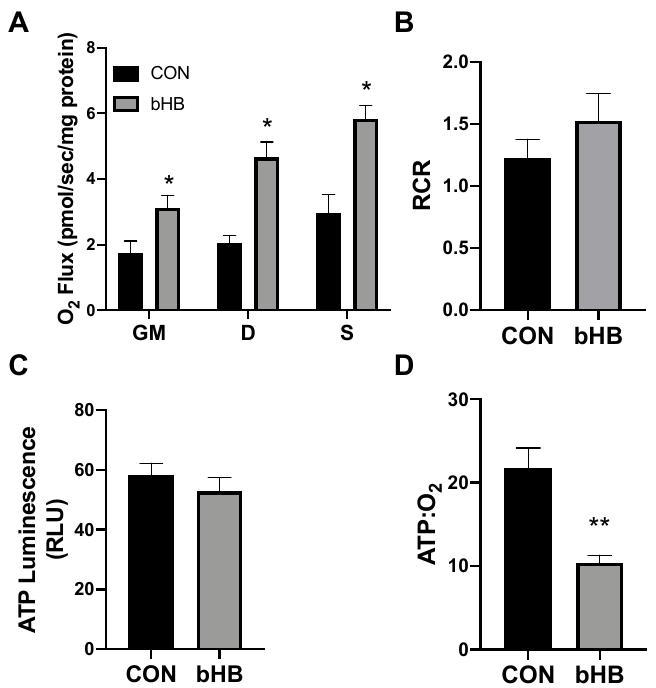
Figure 1. β -hydroxybutyrate ( β HB) alters mitochondrial bioenergetics in cultured adipocytes. Following 24-h treatment with β HB (5 mM), the adipocytes were harvested and used to measure the mitochondrial respiration ( A ) and respiratory control ratio (RCR; B ) in adipocytes. Permeabilized adipocytes were sequentially treated with glutamate (10 mM) and malate (2 mM; GM); +ADP (D; 2.5 mM); +succinate (S; 10 mM). ATP was measured via luminescence from freshly lysed cells ( C ), and the ratio of ATP and respiration was quantified ( D ). n = 5. * p < 0.05. ** p < 0.01.